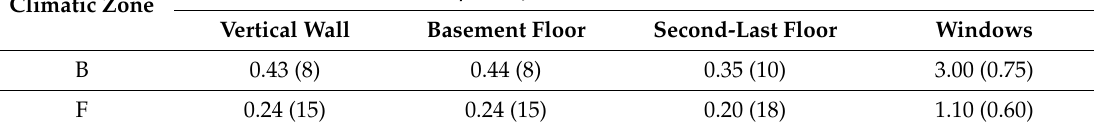
Table 2. Thermal transmittance of opaque walls (with correspondent insulation thickness in cm in round brackets) and windows (with normal solar factor of glazing in round brackets) for the building benchmark in climatic zones B and